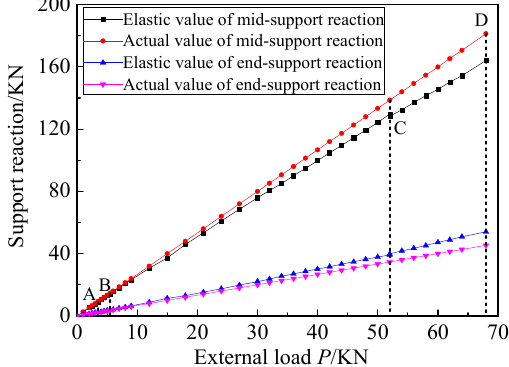
Figure 4. Load versus displacement curve. Figure 5. Comparison of the elastic and test reactions for L-A-2. Figure 5. Comparison of the elastic and Figure 6. Evolution of moment Figure 5. Comparison of the elastic and Figure 6. Evolution of moment test reactions for L-A-2. redistribution for L-A-2 and KL-B-4. test reactions for L-A-2. redistribution for L-A-2 and KL-B-4.